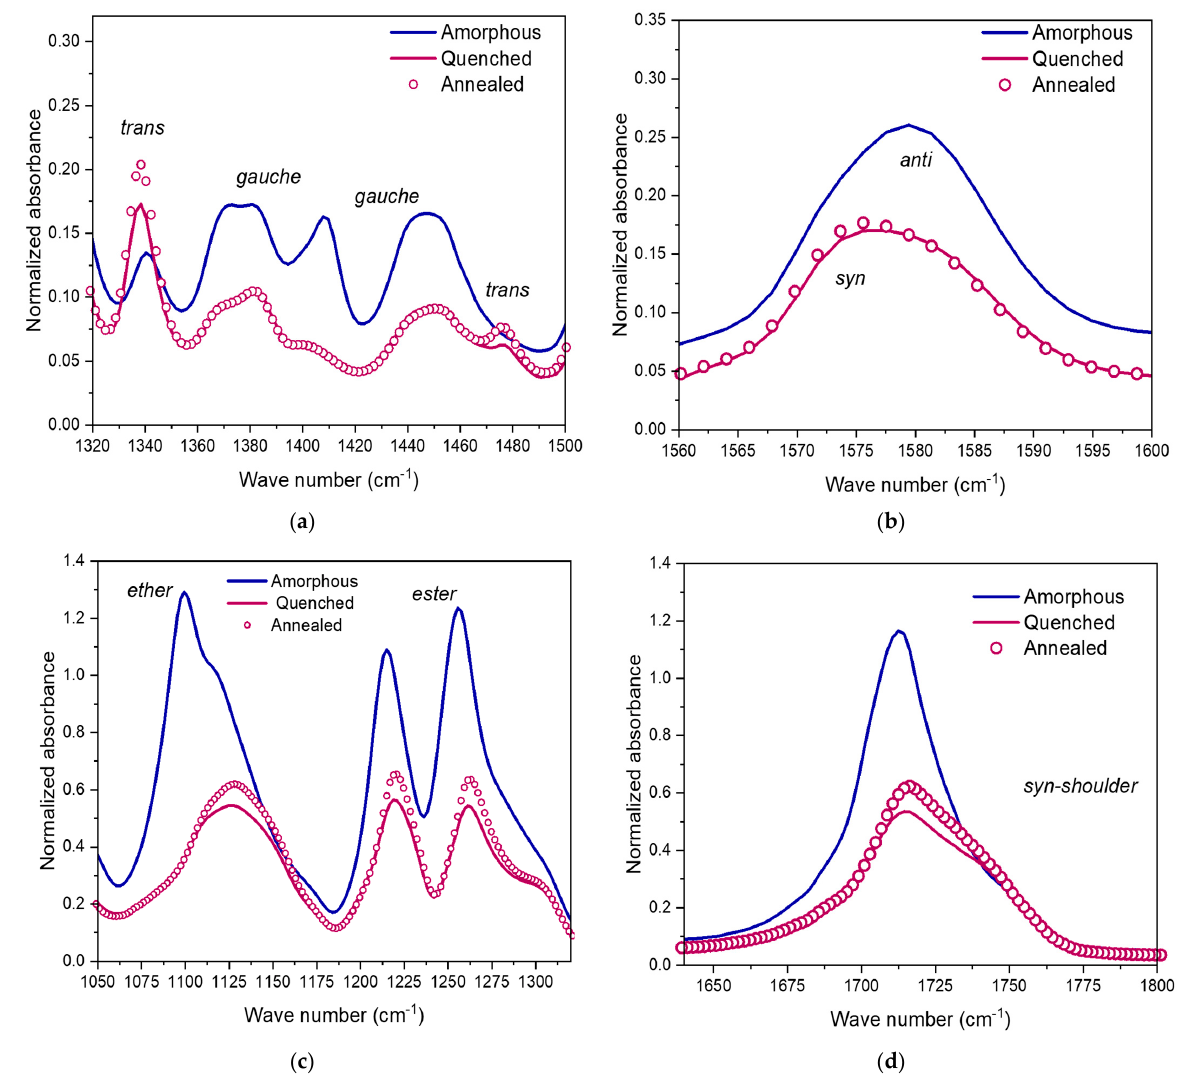
Figure 6. FT-IR spectra of amorphous PEF (blue line), biaxially stretched and quenched PEF (purple lines), biaxially stretched and annealed PEF (purple dots) for wave numbers associated to different chemical groups: ( a ) ethylene glycols (1320 cm − 1 to 1500 cm − 1 ), ( b ) furan cycles (1560 cm − 1 to 1600 cm − 1 ), ( c ) ether and ester groups (1050 cm − 1 to 1320 cm − 1 ), and ( d ) carbonyl area (1630 cm − 1 to 1800 cm − 1